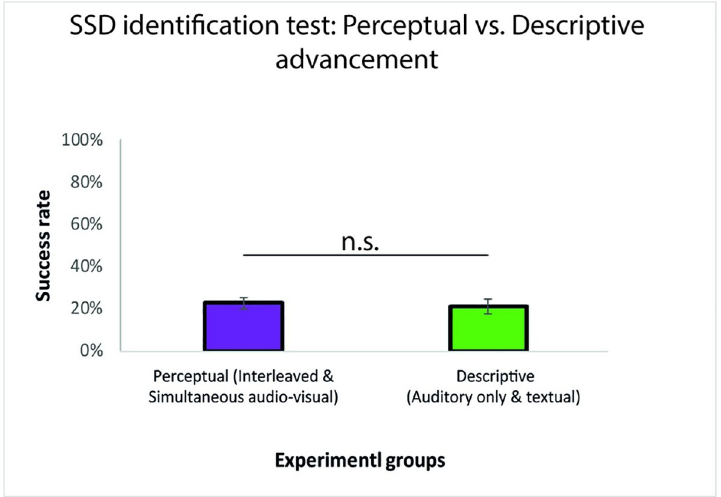
Fig 4. Improvement in accuracy between pre- and post-training SSD identification test for perceptual and descriptive training groups. When pooling together the improvement-in-accuracy index for all perceptual training strategies (interleaved and simultaneous audio-visual multisensory), and the improvement-in-accuracy index for the descriptive training strategies (auditory only unisensory, and audio-visual textual descriptive), no significant difference was found (rank-sum, p = 0.99). Note that the error bars show the standard error.